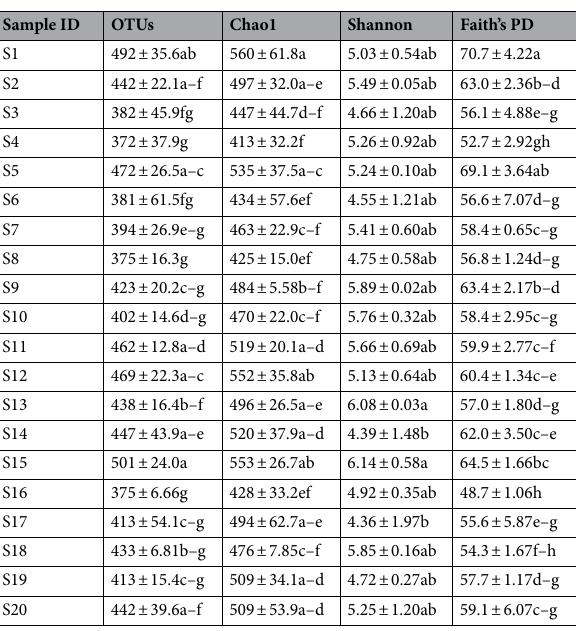
Table 2. Summary of OTUs, Chao 1, Shannon, and Faith’s PD indexes based on relative abundance of fungal sequences at different sites. Different letters represent statistical significance at p < 0.05.